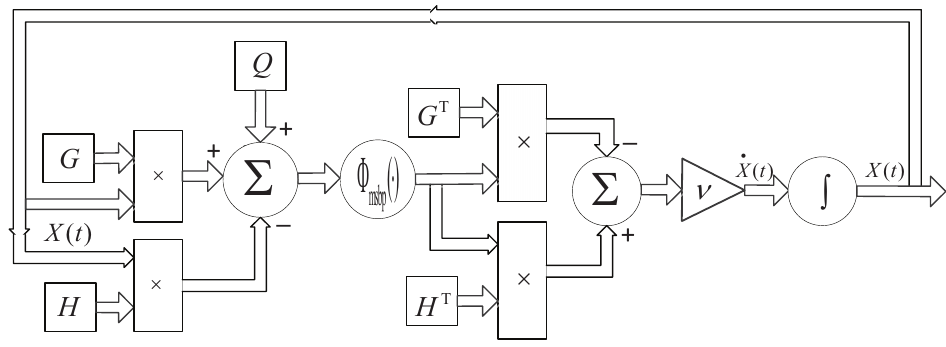
Figure 1. Block diagram of GNN model (9) for solving Sylvester equation. Table 1. Comparison of GNN models (5), (6), and (9) for solving Sylvester equation. GNN Model Activation Function Convergence Property